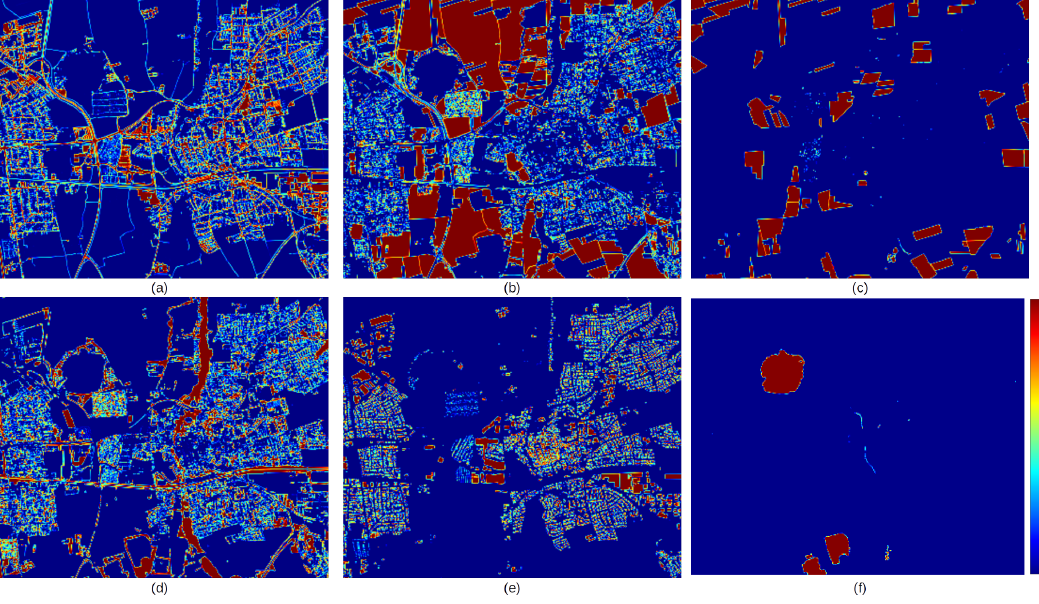
Figure 13. Ground truth of abundance maps of the sub3 region of the EeteS_EnMAP_10 data. (a) Pavement. (b) Low vegetation. (c) Soil. (d) Tree. (e) Roof. (f)